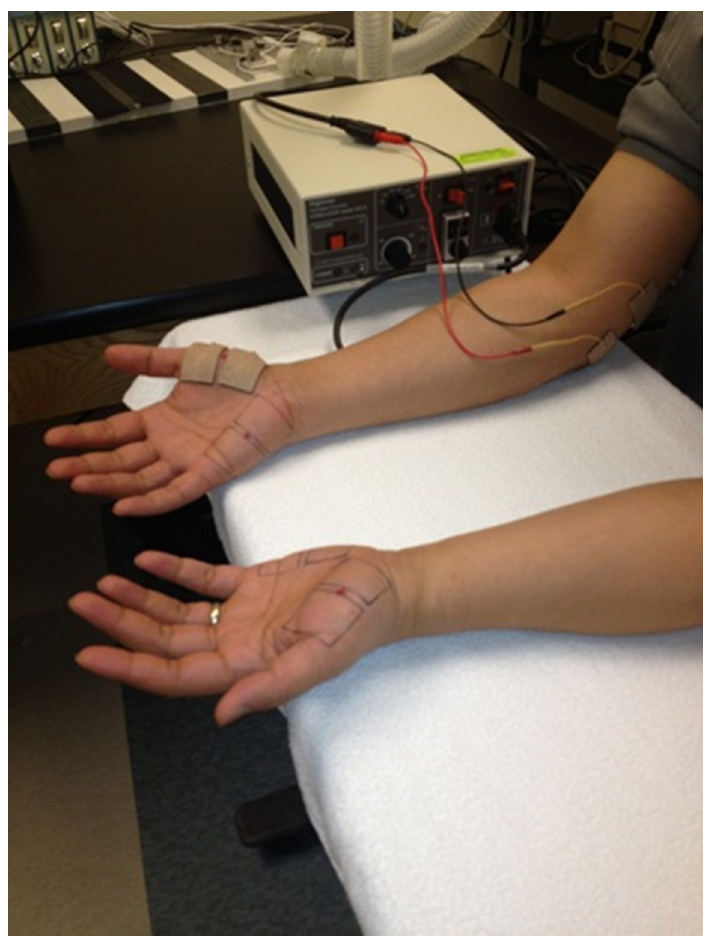
Figure 1. Experimental Set-up.